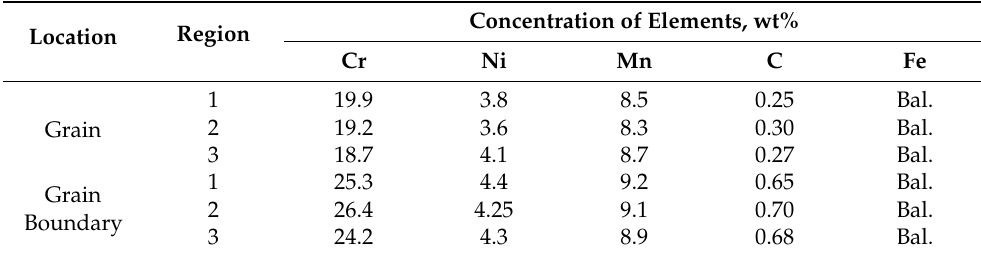
Table 3. EDS concentration of elements both at grain boundaries and